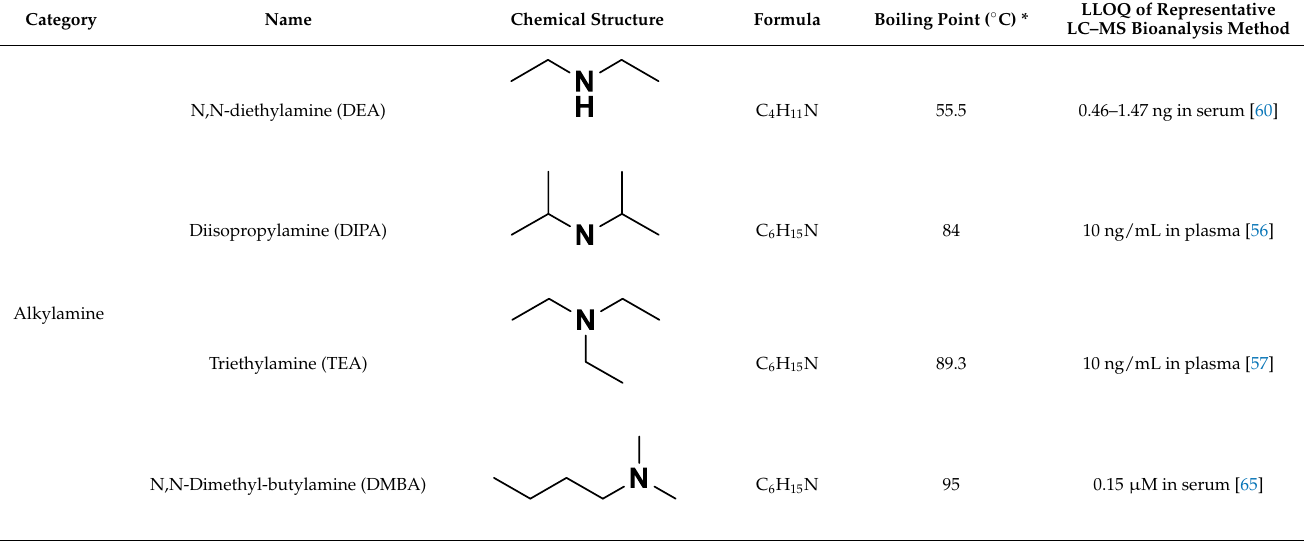
Table 4. Alkylamines and fluorinated alcohols (organized in the order of increased boiling point) used in the ion pairing reversed-phase liquid chromatography – mass spectrometry.